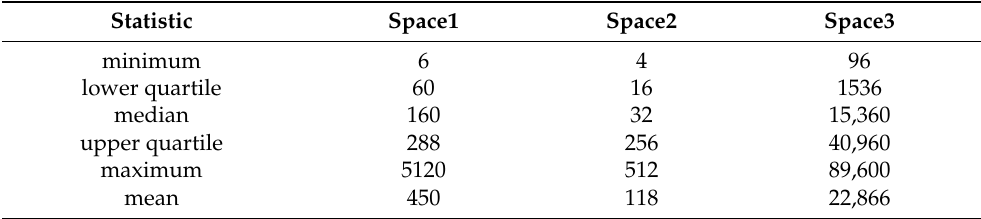
Table 4. Summary statistics for the number of possible tests using the three search